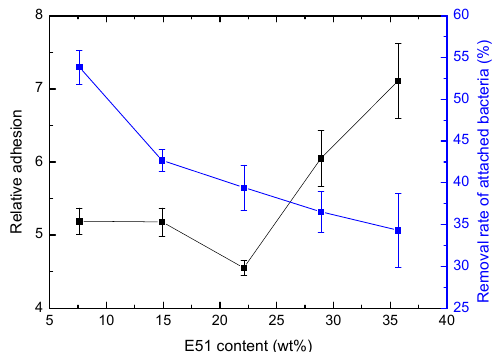
Figure 9. Relative adhesion and bacterial removal rate with E51 content.